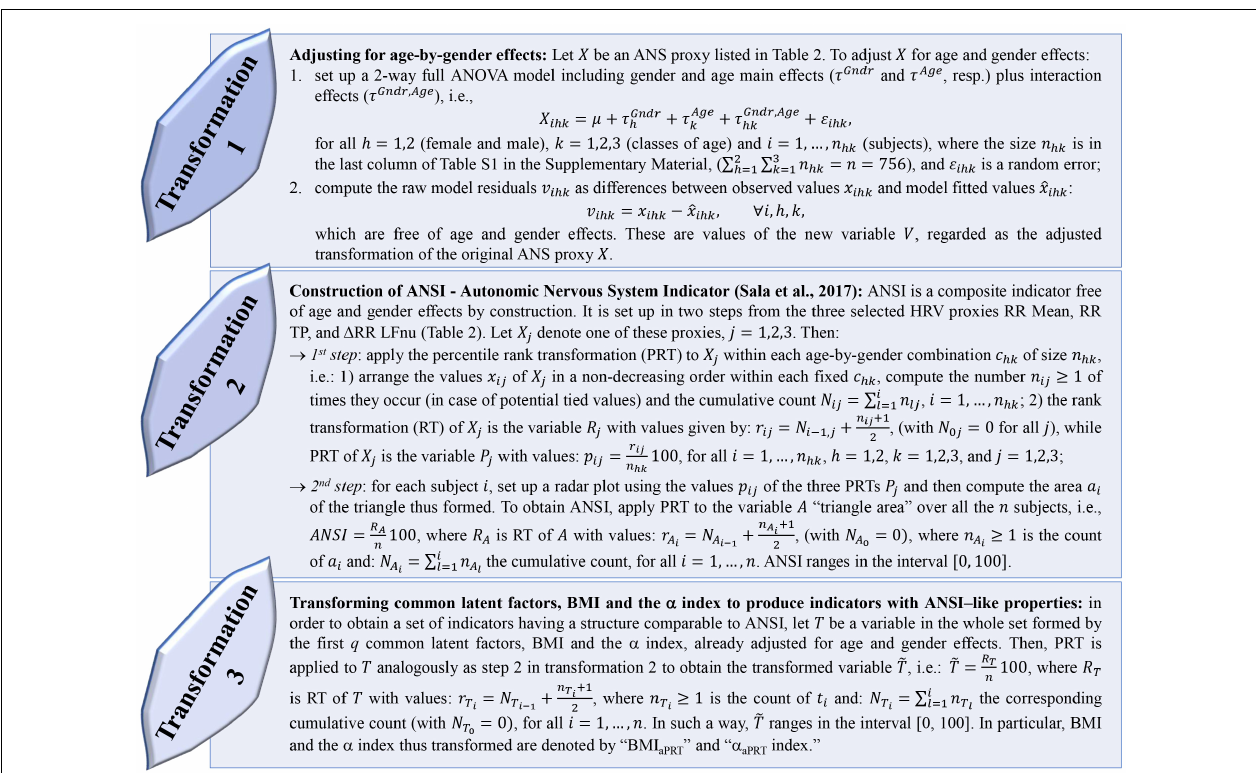
FIGURE 1 | Transformations applied to the original variables to set up CAR